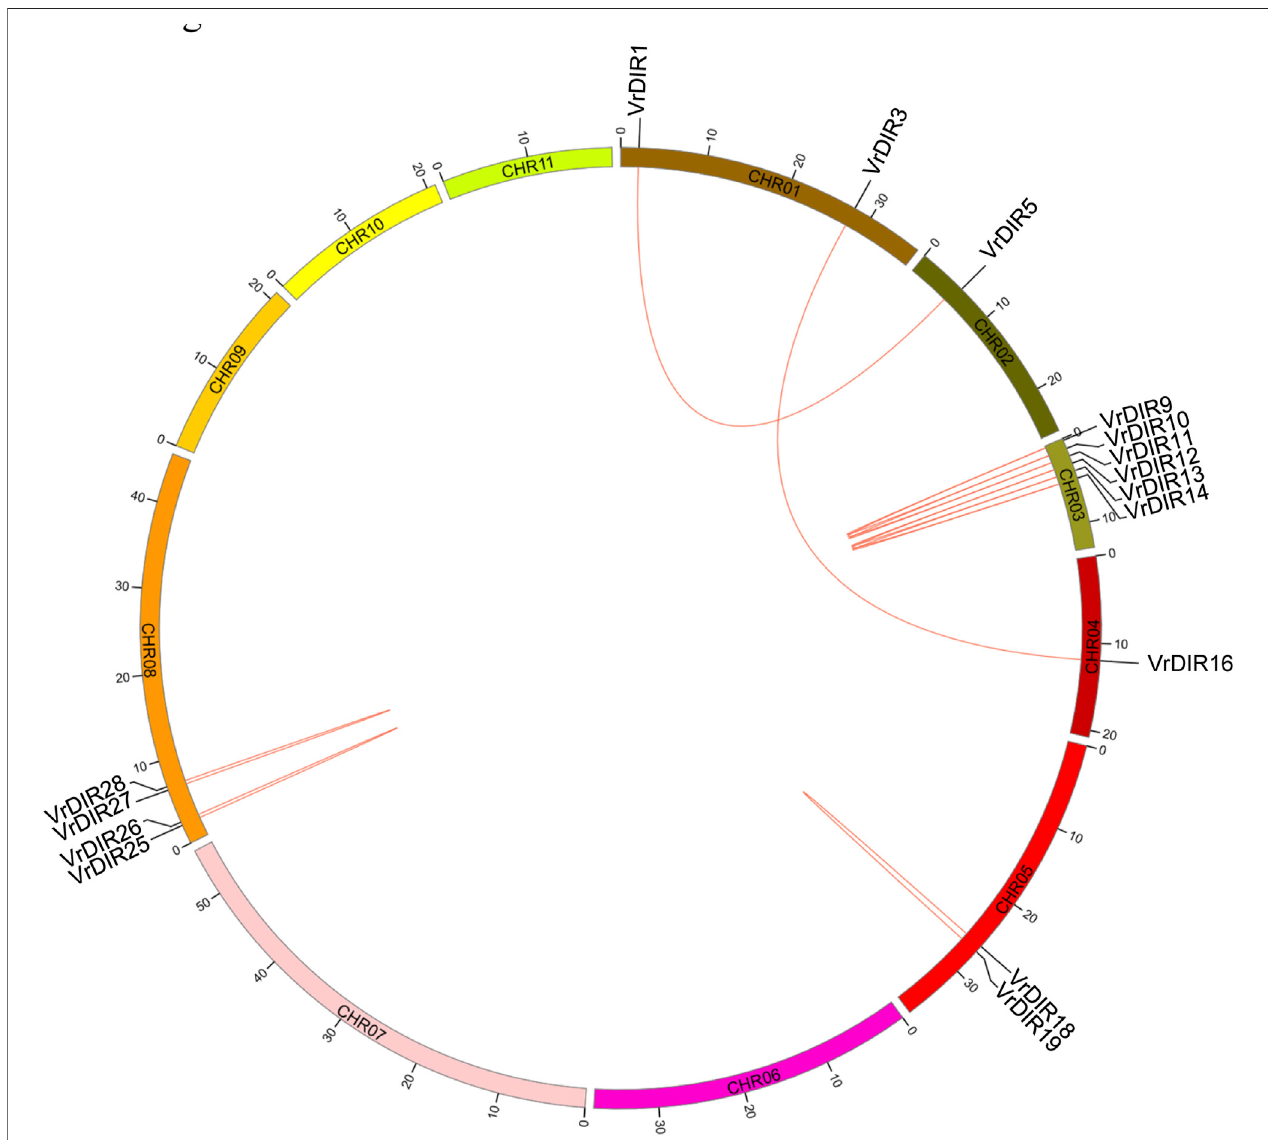
FIGURE 4 | Duplication analysis of VrDIR genes. The positions of VrDIR genes in each chromosome are presented, and the duplicated gene pairs are connected using red lines. The length of each chromosome is indicated, and CHR indicates chromosome.